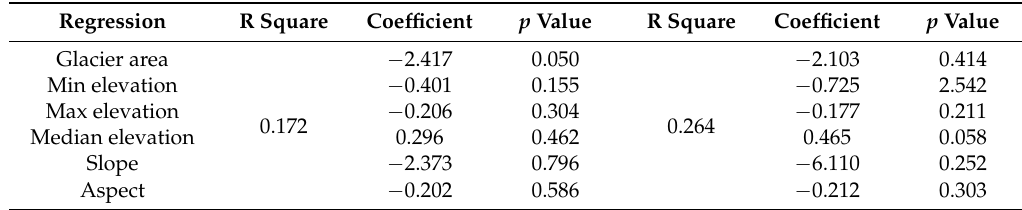
Table 7. Regression analysis between glacier terminus advance (56 observations, left) and retreat (77 observations, right) with glacier parameters.